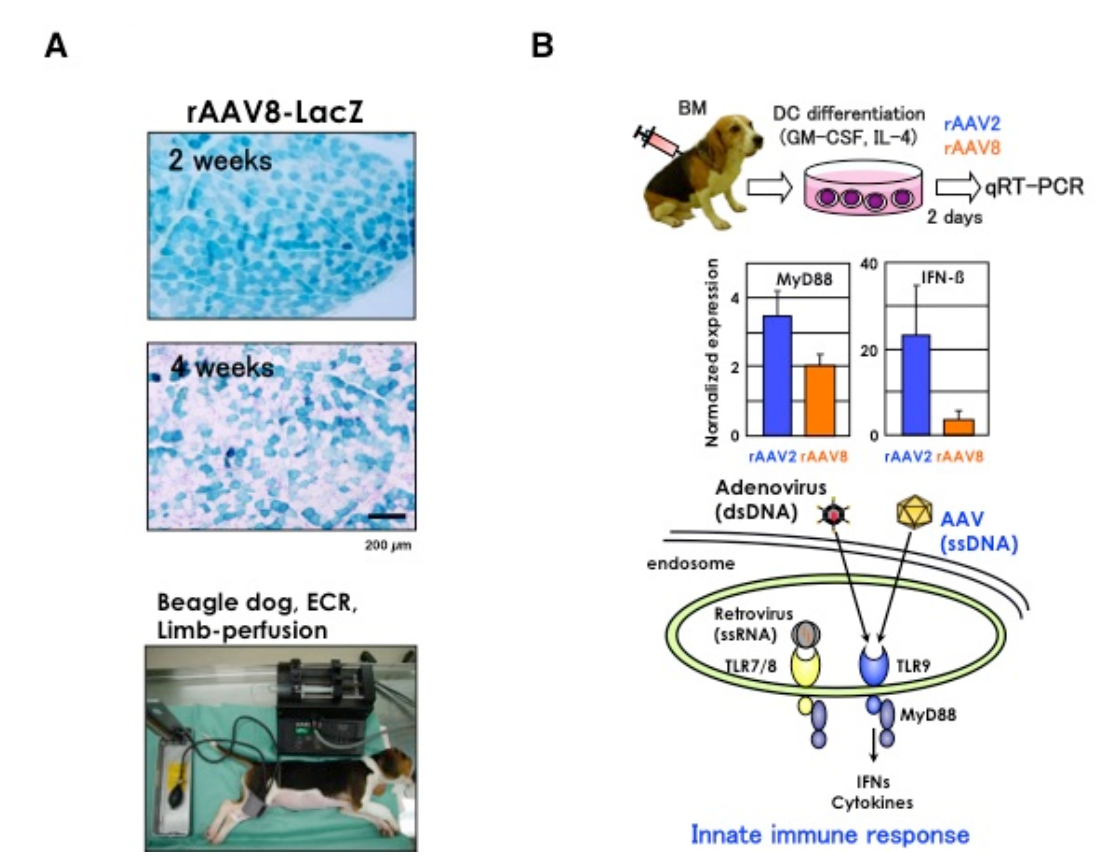
(HSPG) receptor, which would permit virion shuttling into a DC pathway, as cross-presentation [85]. Exposure to vectors from other AAV clades, such as AAV8, did not activate capsid-specific T-cells. Figure 3. rAAV-mediated transduction of dog. ( A ) Intravascular vector administration by limb perfusion. A blood pressure cuff is applied just above the knee of an anesthetized CXMD dog. A 24-gauge intravenous catheter is inserted into the lateral saphenous vein, J connected to a three-way stopcock, and flushed with saline. With a blood pressure cuff inflated to over 300 mmHg, saline (2.6 mL/kg) containing papaverine (0.44 mg/kg, Sigma- Aldrich, St. Louis, MO) and heparin (16 U/kg) is injected by hand over a 10 second period. The three-way stopcock is connected to a syringe containing rAAV8 (1 × 10 14 vg/kg, 3.8 mL/kg). The syringe is placed in a PHD 2000 syringe pump (Harvard Apparatus, Edenbridge, UK). Five minutes after the papaverine/heparin injection, rAAV8-LacZ is injected at a rate of 0.6 mL/sec. Two minutes after the rAAV injection, the blood pressure cuff is released and the catheter is removed. Four weeks after the transduction, the expression slightly fell off. ( B ) AAV-mediated stimulation of innate immune response via TLR9/MyD88 pathway. Bone marrow (BM)-derived dendritic cells (DCs) were obtained from humerus bones and cultured in RPMI (10% FCS, p/s) for 7 days with canine GM-CSF and IL-4. DCs were transduced with rAAV2- or rAAV8- lacZ (1 × 10 6 vg/cell for 4 h, and mRNA levels of MyD88 and IFN- β were analyzed. Untransduced cells were used as a normalization standard to demonstrate relative value of expression. Results are representative of two independent experiments. Error bars represent s.e.m., n =